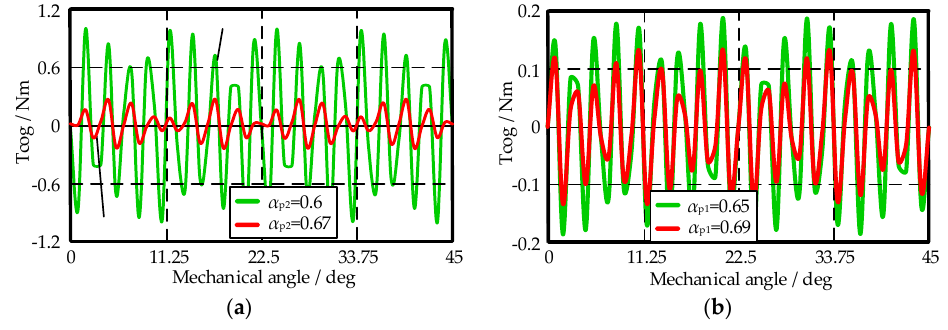
Figure 16. Comparison of cogging torques for the different pole arc ratio: ( a ) The influence of outer pole arc ratio α p2 ; ( b ) The influence of inner pole arc ratio α p1 .